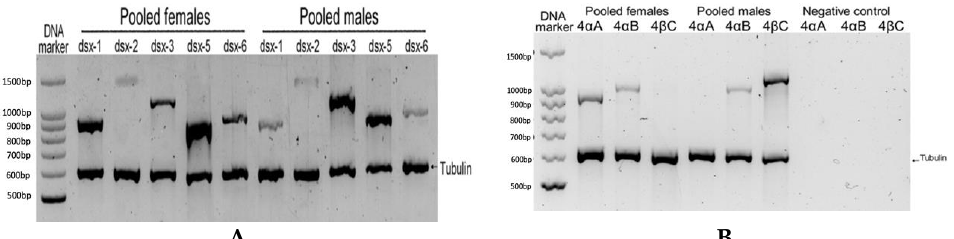
Figure 1. The evidence of transcription of Dsx/Dmrt genes from the cDNA samples of the pooled adult females and pooled adult males in A. franciscana . ( A ): The presence of dsx -1, dsx -2, dsx -3, dsx -5 and dsx -6 transcripts by semi-quantitative PCR (tubulin was used as the internal control). ( B ): The alternative transcript of A. franciscana Af.dsx-4 , including dsx- 4αA , dsx- 4αB and dsx- 4βC , confirmed the presence by PCR from the cDNA of the pooled adult animals.